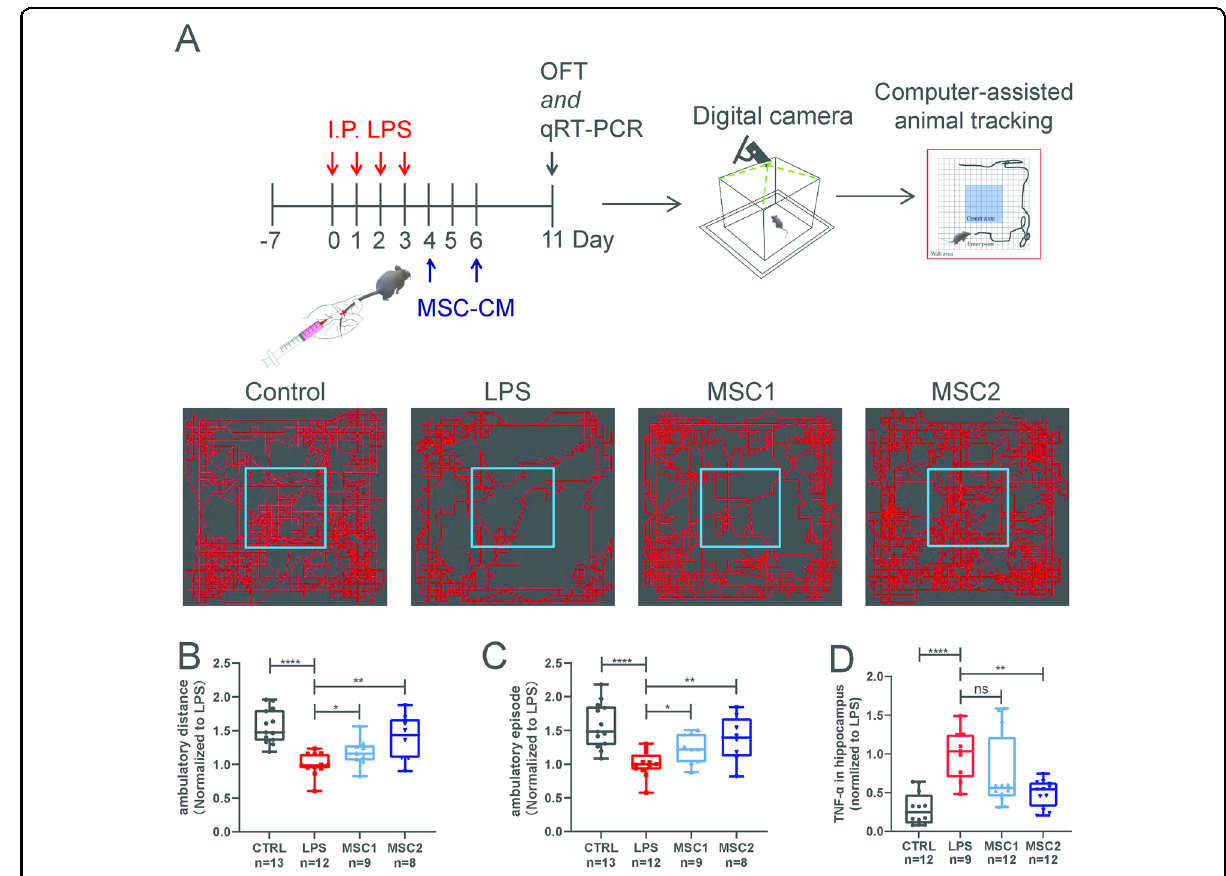
Fig. 2 Donor-dependent variations in immune modulation of huMSCs in LPS-induced neural in fl ammation animal model in vivo. A Schematic diagram shows in vivo assessment MSC-CM treatment ef fi cacies in LPS-induced neuroin fl ammation animal model. Open- fi eld-test was used as the main behavioral readout. Boxplots show ambulatory distance ( B ) and episodes ( C ) of the open- fi eld-test of each treatment groups. All data were normalized to the average value of the LPS group. D Boxplot shows in fl ammatory factors TNF- α mRNA levels in hippocampus of each group. Data were also normalized to the average value of the LPS group, and presented as mean ± SEM, * P < 0.05, ** P < 0.01, **** P <